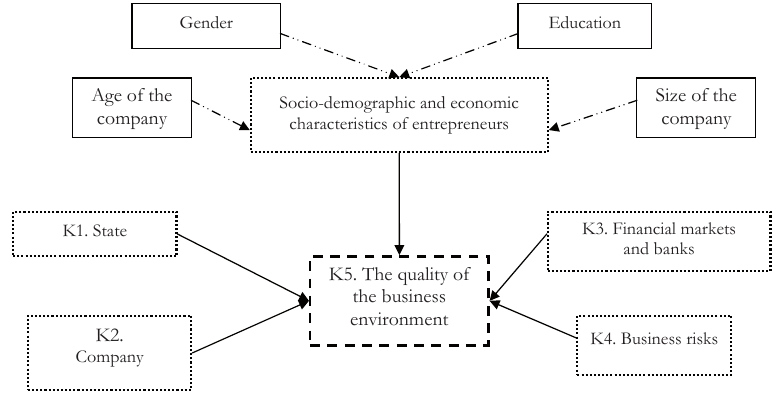
Fig. 1 - The structural model in the field of the quality of the business environment and the credit risk of SME. Source: own